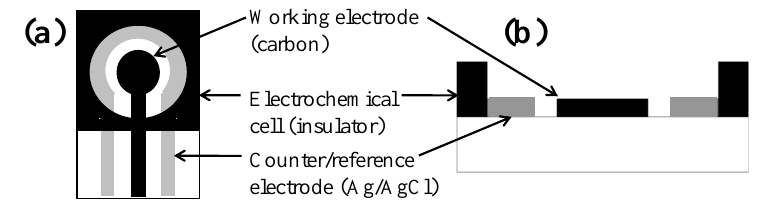
Figure 1. The sensor is composed of two electrodes: the inner carbon/graphite working electrode, having a diameter of 4 mm, and the outer silver/silver chloride counter/reference electrode. A 200 μL capacity sample well is defined by an insulating foam. Every SPCE sensor was rinsed with sterile DI water and allowed to dry before test solution was applied. Sensors were disposed of after a single use. Figure 1. Schematic of the SPCE sensor: ( a ) top view; ( b ) cross-sectional